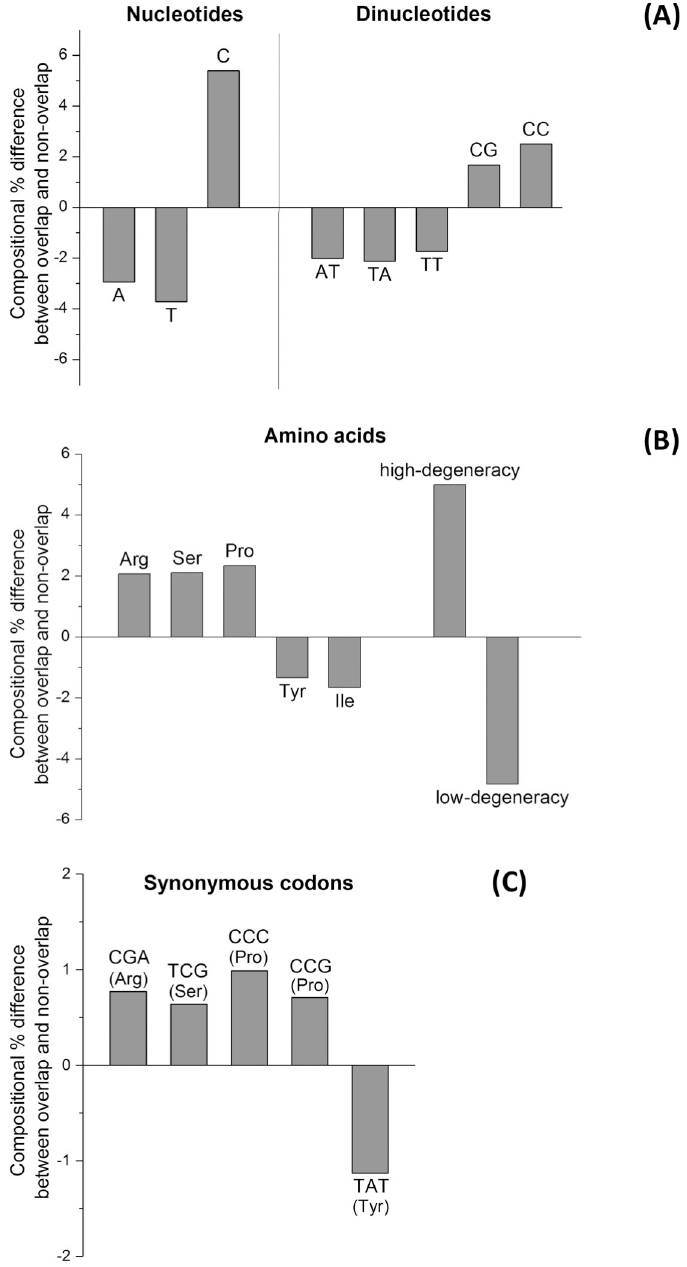
Fig 3. Difference between the pooled sets of overlapping and non-overlapping genes for the 20 most critical composition features. (A) Nucleotides and dinucleotides. (B) Amino acids and amino acids grouped in accordance to codon degeneracy. (C) Synonymous